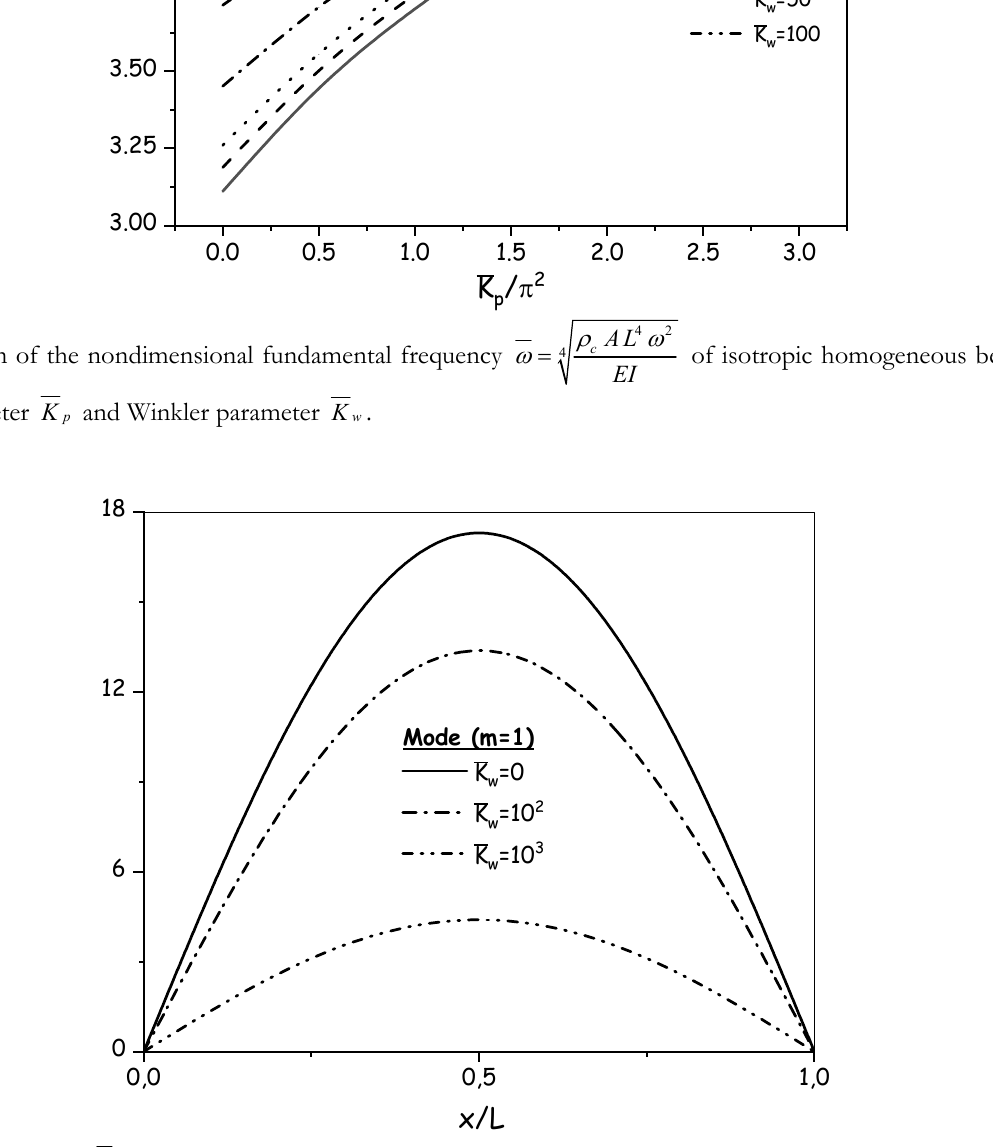
Figure 5: Mode shape of w at the base surface of the beam with various aspect ratios for the first mode frequency